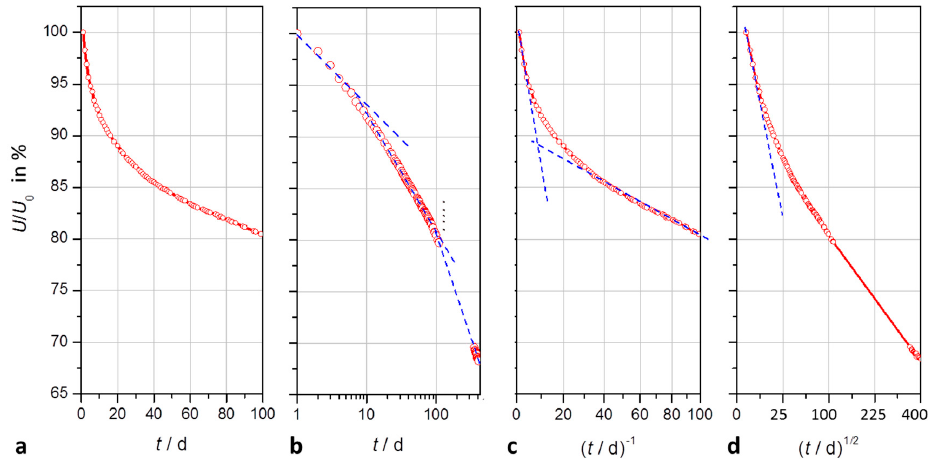
Figure 3. Modeling of the self-discharge of a supercapacitor (2.7 V, 50 F) within 100 days and 400 days, respectively: ( a ) quasi-exponential decay of open-circuit voltage versus time on a linear scale; ( b ) logarithmic scale showing three time domains; ( c ) voltage versus the reciprocal of time with asymptotes for short and long times; ( d ) voltage versus the square root of time; a linear relation holds for diffusion processes. Table 1. Fitting of the time-dependent self-discharge U / U 0 of different supercapacitors by Prony series after approximately 600 days: Coefficients a i are dimensionless ( V / V ), time constants T i in days (1 d = 24 h). Important time constants are printed in bold.